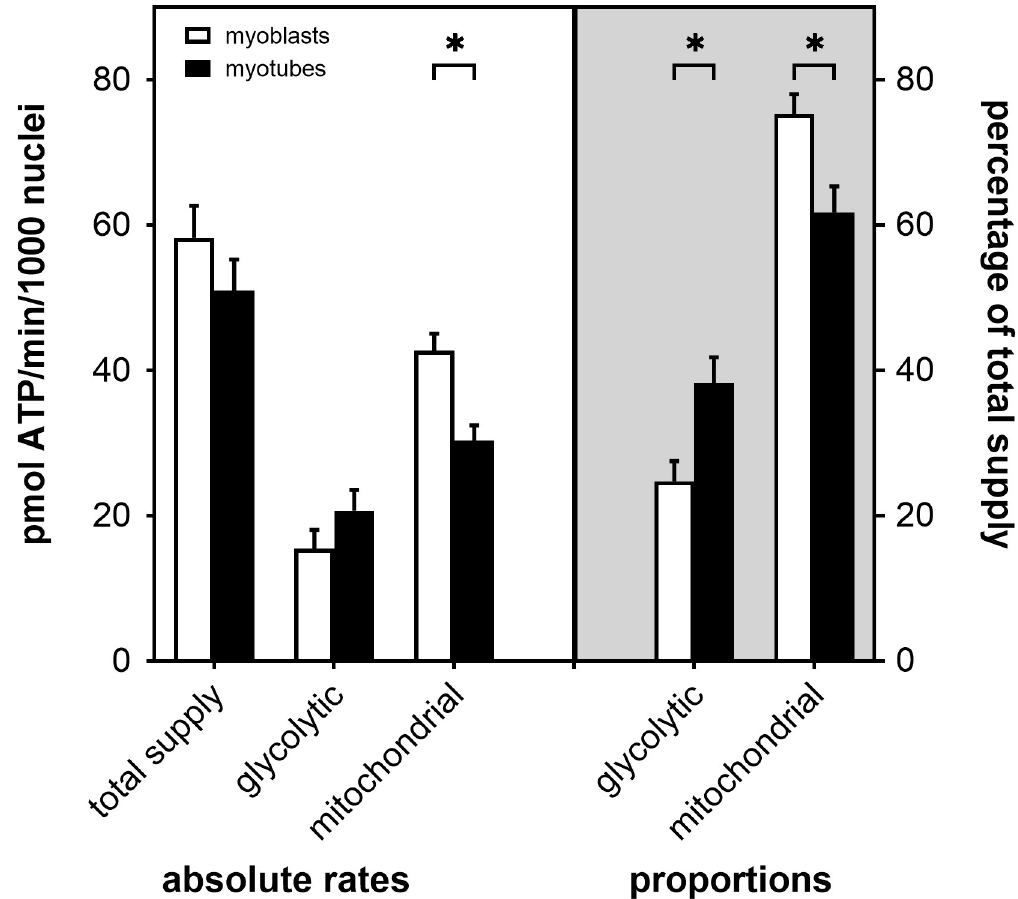
Fig 2. Myocellular ATP supply. Rates of glycolytic and mitochondrial ATP synthesis were calculated from data shown in Fig 1C and were normalised to number of myocyte nuclei (absolute rates) or expressed as percentage of the combined, i.e., total ATP supply (proportions). Myoblast (open bars) and myotube (filled bars) data are means ± SEM of 13–14 well measurements sampled from 4 separate XF assays. Bioenergetic differences between myoblasts and myotubes were evaluated for statistical significance by 2-way ANOVA applying a Sˇı´da´k’s multiple comparisons test ( � P < 0.05).